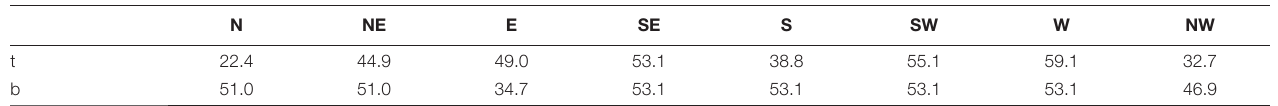
TaBle 4 | Representation of Directions among participants' largest